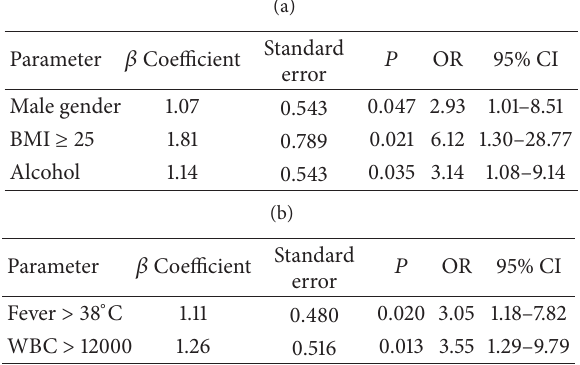
Table 6: (a) Risk factors for diverticulitis in the young after logistic regression analysis. (b) Risk factors for complicated diverticulitis regardless of